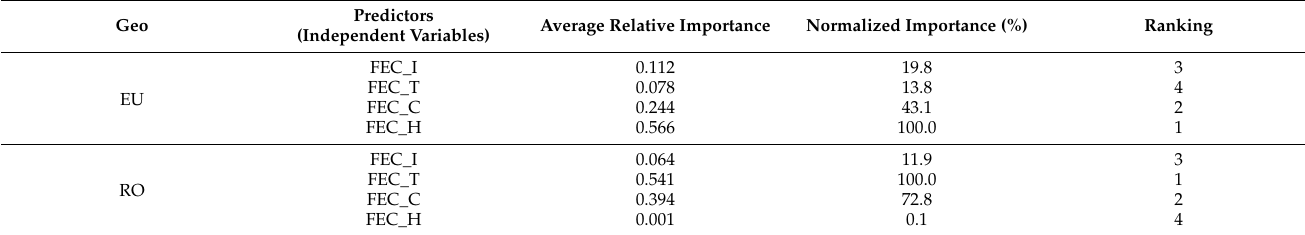
Table 6. Normalized and relative importance by variable.